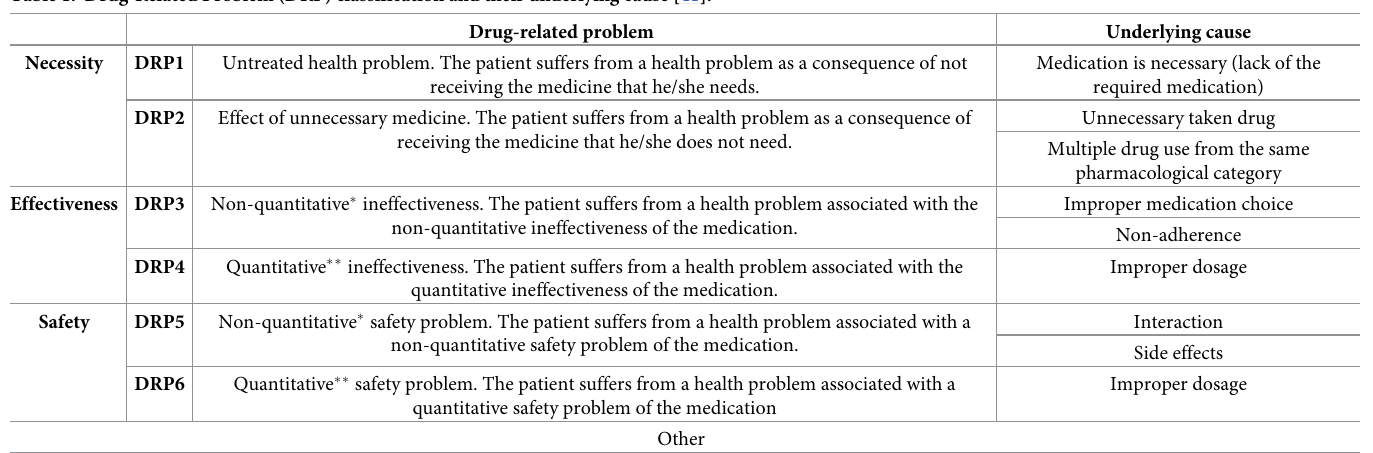
Table 1. Drug-Related Problem (DRP) classification and their underlying cause [41].